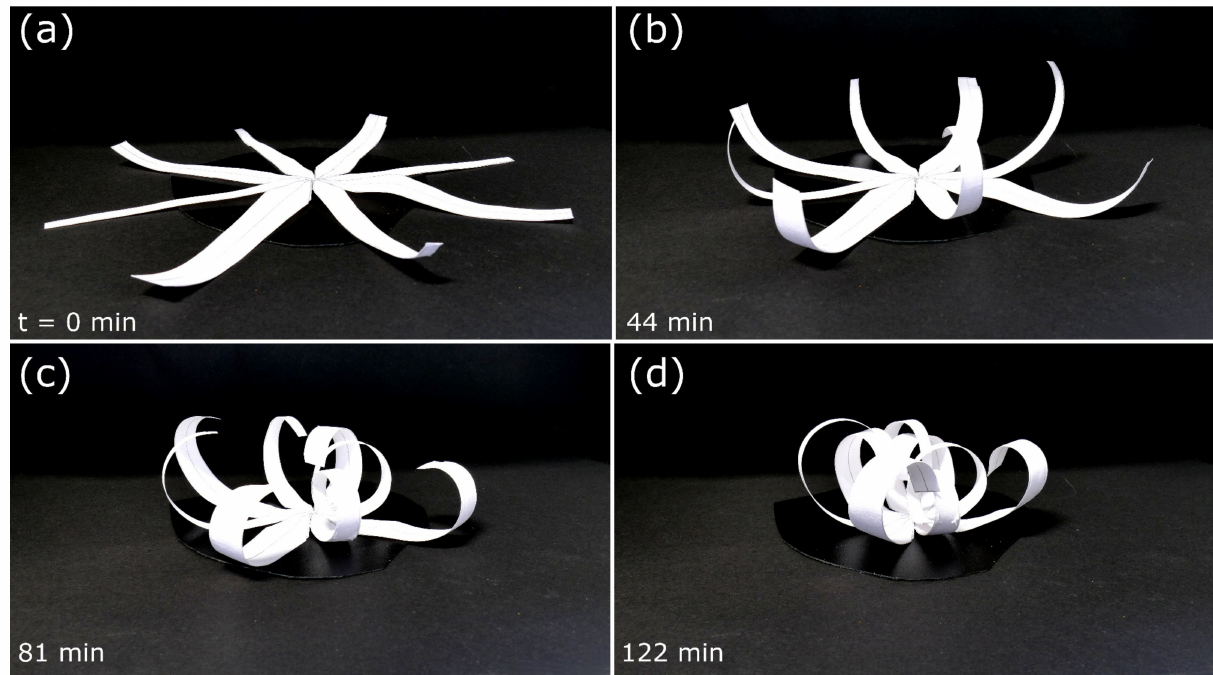
Figure 12. Self-actuated paper-based compliant system inspired by the composite architecture of S. lepidophylla performing closure upon drying. ( a – d ) Folding sequence during desiccation. Time is indicated bottom